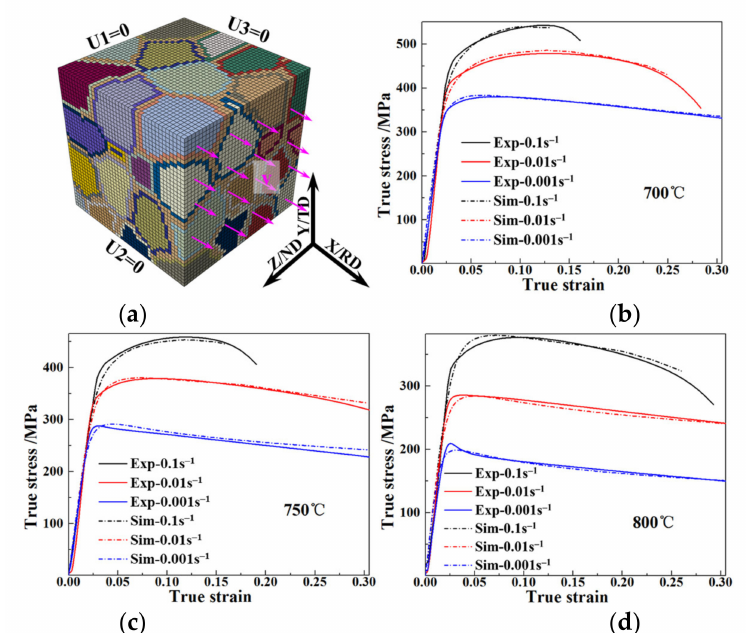
Figure 5. Boundary conditions of polycrystalline model and the comparison of simulated and experi- mental true stress–strain of TA15 sheet during hot tension. ( a ) Boundary condition of polycrystalline model; true stress–strain at 700 ◦ C ( b ), 750 ◦ C ( c ) and 800 ◦ C ( d